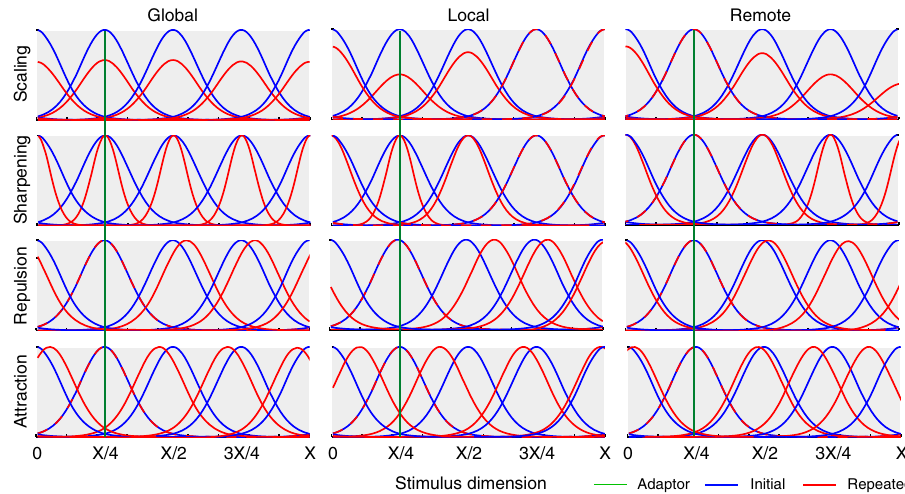
Fig. 1 Example tuning curves along a stimulus dimension (ranging from 0 to X), both before (blue) and after (red) repetition of a single stimulus (with value X/4, shown by green line) according to the twelve different neural models of repetition suppression, created by crossing four mechanisms (rows) with three domains (columns). Mechanisms: scaling – adaptation reduces response amplitude, sharpening – adaptation tightens tuning-curves, repulsion – the peak of tuning-curves moves away from the adapting stimulus, attraction – the peak moves towards the adapting stimulus. Domains: global – all tuning- curves in a voxel are affected, local – tuning-curves close to the adapting stimulus are affected most, remote – tuning-curves close to the adapting stimulus are affected least. For illustrative purposes, only fi ve neural populations are shown, equally-spaced along the stimulus dimension. Note that this fi gure illustrates the Gaussian tuning-curves used for Experiment 1 (see Supplementary Figure 1 for illustration of von Mises tuning-curves used for Experiment